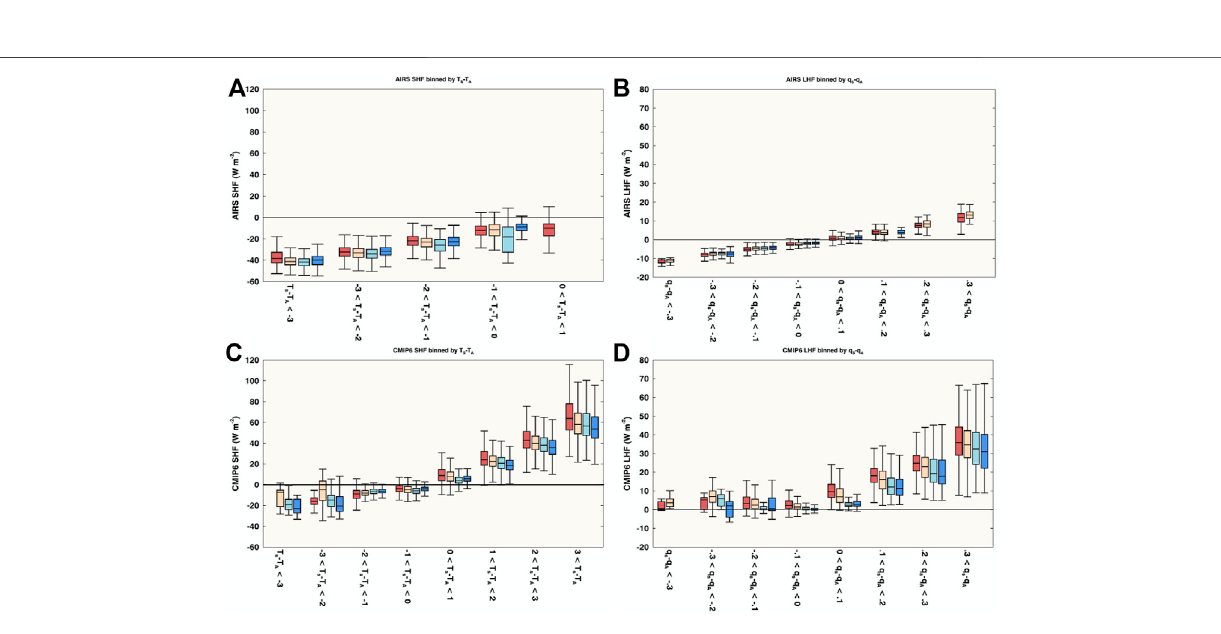
FIGURE 7 | Arctic winter (ONDJ) SHF (LHF) binned by T S − T A ( q S − q A ) for AIRS (A,B) and CMIP6 (C,D) . Data is further separated into the four ice loss regimes, denotedbycolor:fastloss(red),moderateloss(yellow),slowloss(lightblue),andpersistentregimes(royalblue).Ifagiven